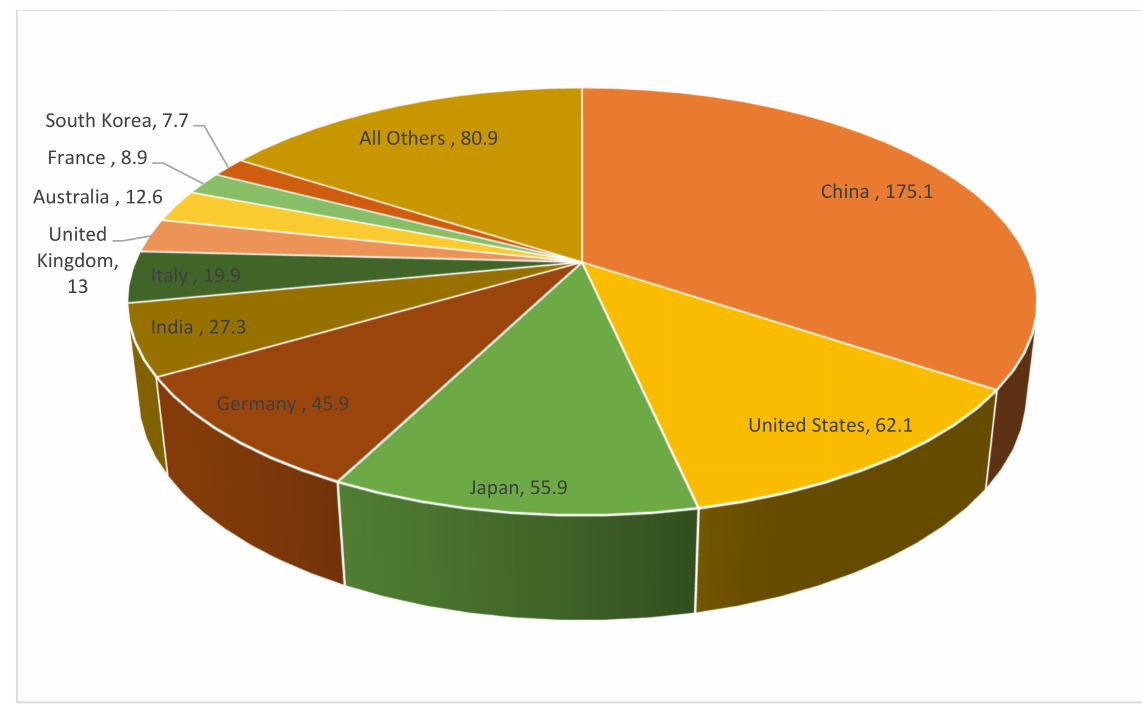
Figure 3. Total cumulative capacity of installed PV by country [83]. ( a ) For 2018 and ( b ) for